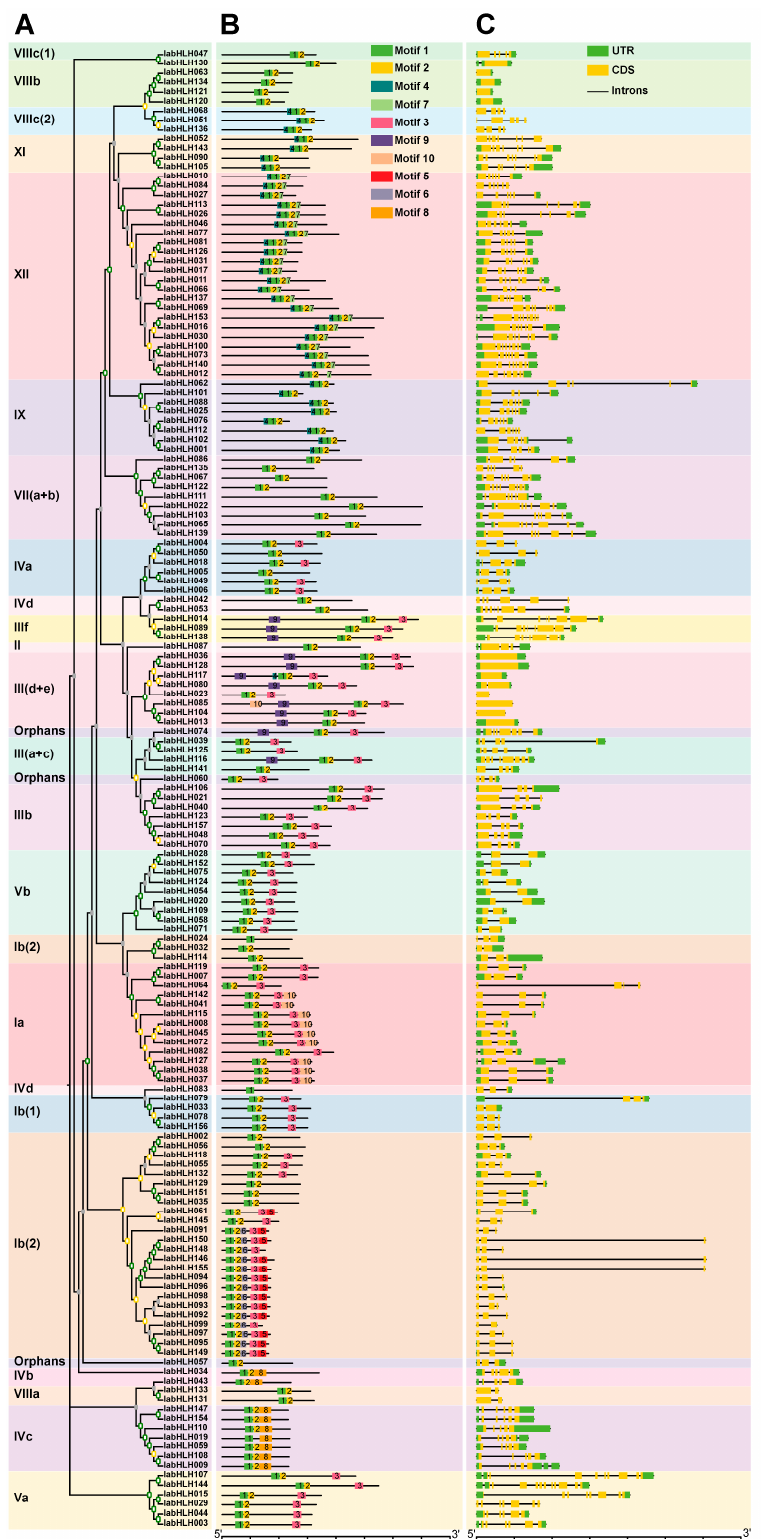
Figure 5. Phylogenetic tree, conserved motif, and exon-intron structure of IabHLHs. ( A ) The phylo- genetic tree containing 157 IabHLH protein sequences; ( B ) distribution of conserved motifs within IabHLH proteins. The rectangles with different colors represent different motifs; ( C ) exon-intron structure of the 157 IabHLH genes. The green rectangles indicate exons, while the orange rectangles indicate untranslated regions (UTRs). The black solid lines among the rectangles indicate